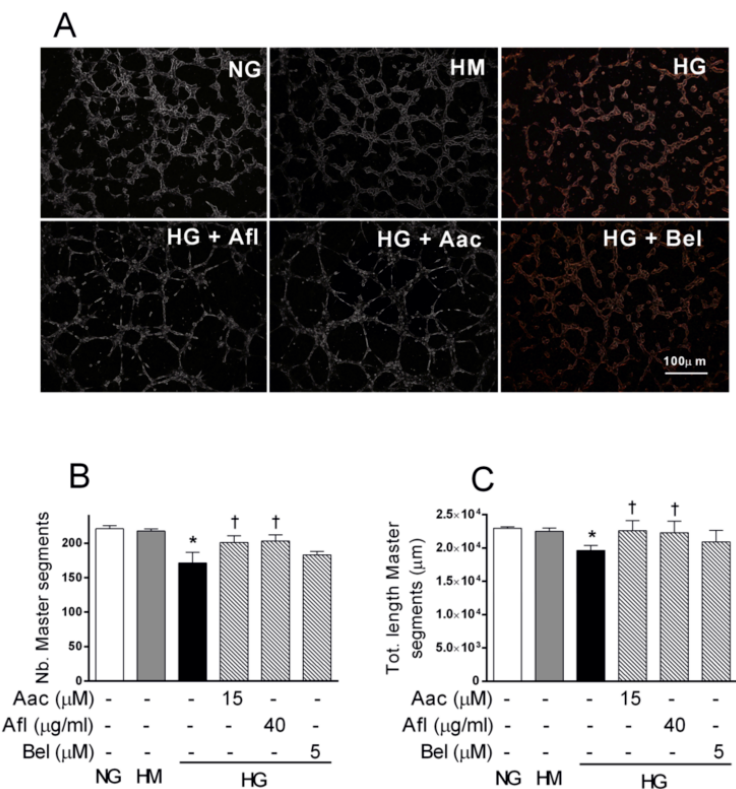
Figure 2. Aflibercept and cPLA2 inhibitor AACOCF3 increased the tube-like structures assessed by tube formation assays in human retinal endothelial cells (HRECs) treated with high glucose (HG). HRECs were seeded into the 96-well plate coated with Matrigel at a density of 1.5 × 10 4 /well in presence of normal glucose (NG, 5 mM), or high mannitol (HM, 25 mM) or high glucose (HG, 25 mM) alone or supplemented with Aflibercept (Afl, 40 µg/mL), of cPLA2 inhibitor (Aac, 15 µM) or iPLA2 inhibitor (Bel, 5 µM). After 4 h, tube-like structures were photographed and the images were analyzed with Image J software. Panel ( A ) shows representative photographs of tube-like structures. Quantitative analysis of total number and length of tube-like structures are shown in panels ( B ) and ( C ), respectively. Values are expressed as a mean ± SEM of three independent experiments, each run in triplicate. * p < 0.05 vs. CTRL; † p < 0.05 vs. HG alone. One-way ANOVA, followed by Tukey’s test. The HREC capacity to form tubes was unaffected by HM. Treatment with 40 µg/mL Aflibercept or 15 µM of AACOCF3 significantly prevented the reduction of tube-like structures induced by HG. In fact, analysis of the tube-like structures showed number and length of master segments similar to controls (Figure 2, panels B and C, respectively). Co-treatment with HG and 5 µM of BEL barely